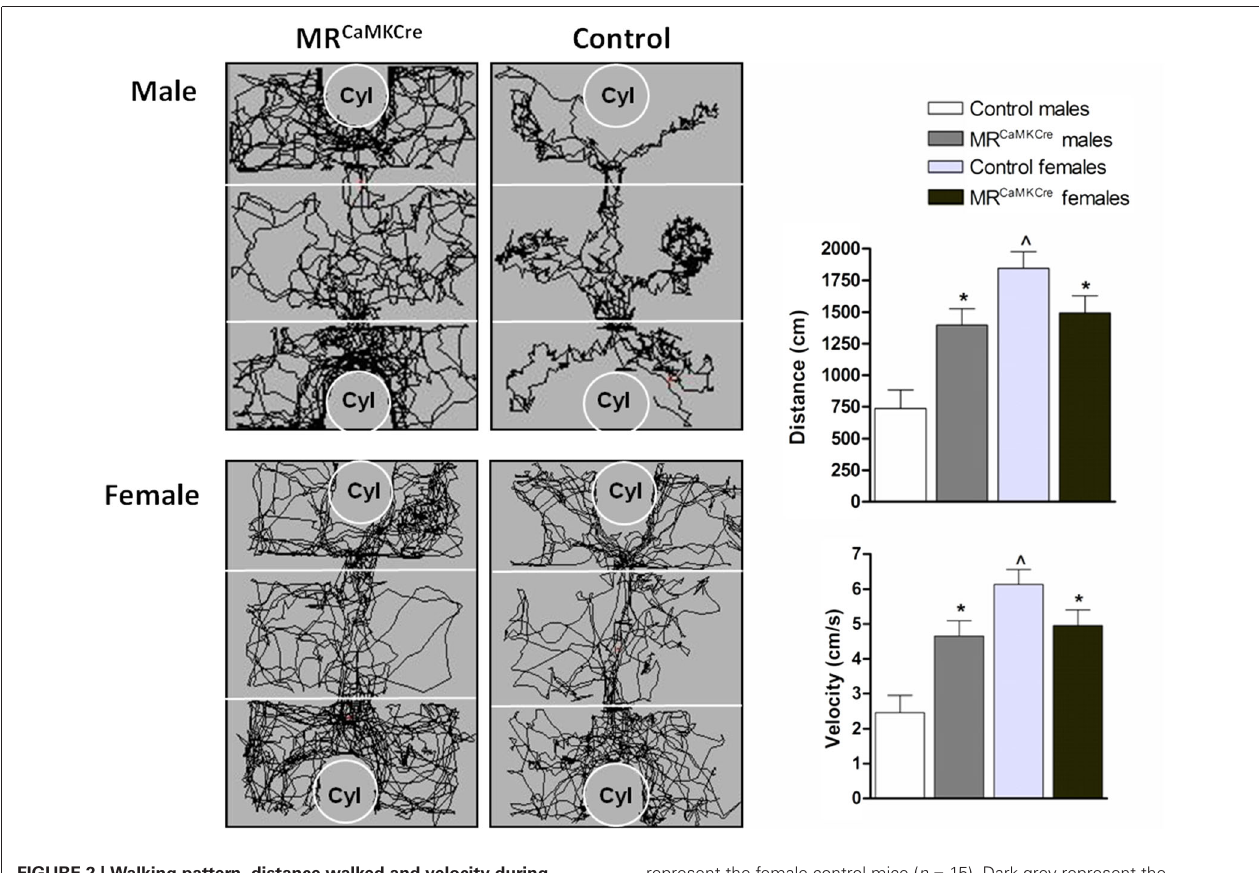
FIGURE 2 | Walking pattern, distance walked and velocity during habituation . Male MR CaMKCre mice showed increased locomotion compared to control littermates. Female MR CaMKCre showed decreased locomotor activity compared to their control littermates. White bars represent control males ( n = 9) and light grey bars